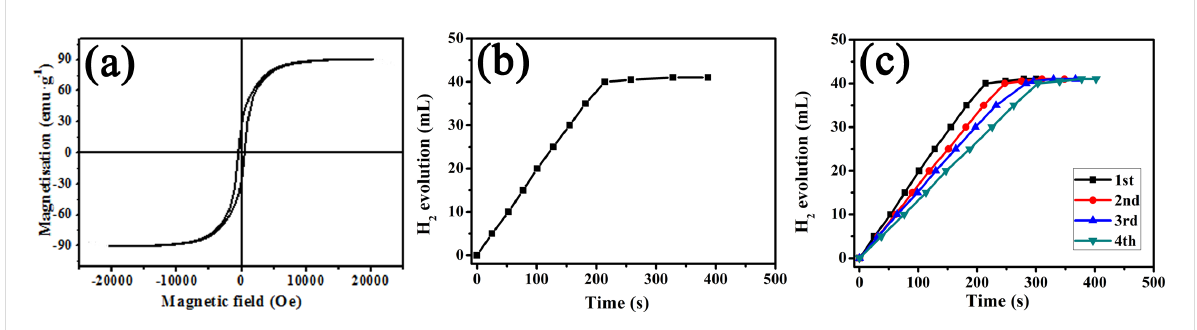
Figure 5: (a) Magnetic hysteresis loop of bimetallic Co–Cu nanowires, (b) time plots of catalytic hydrolysis of AB and (c) hydrogen generation from AB catalyzed by bimetallic Co–Cu nanowires from the 1st to 4th cycles.